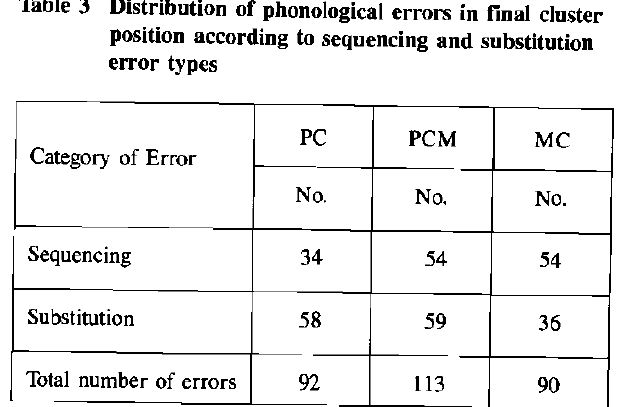
Table 3 Distribution of phonological errors in final cluster position according to sequencing and substitution